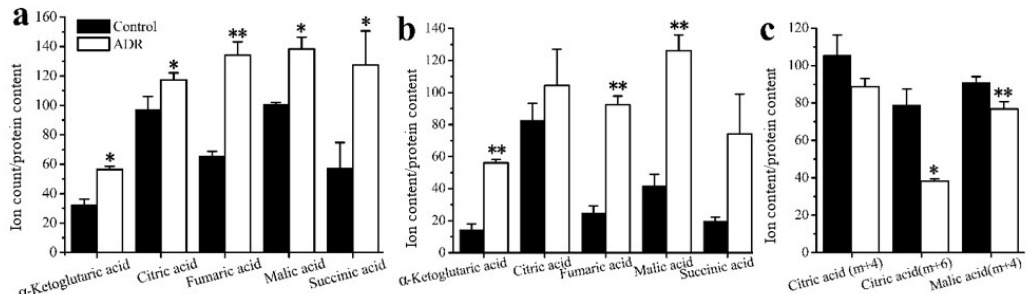
Figure 5. Distribution of the isotopologues of TCA cycle intermediates for non-treated cells and ADR-treated cells ( a ) (m + 2) levels of intermediates in MCF7 cells; ( b ) (m + 2) levels intermediates in MDA-MB-231 cells; ( c ) (m + 4) and (m + 6) isotopologues of citrate and malate. * signifies p < 0.05 and ** signifies p <